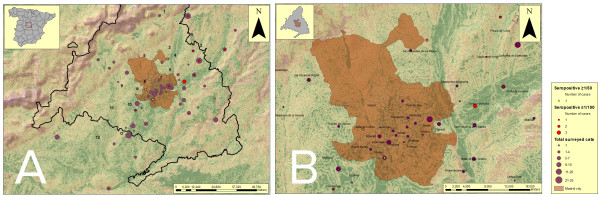
Geocoded sites where the cats were captured, shown on a digital elevation model. A. Distribution of cats seropositive for L. infantum (IFAT titre ≥ 1:50) in the study area. B. Detailed distribution of cats seropositive for L. infantum (IFAT titre ≥ 1:50) in the Madrid city area. 1: Uceda (Guadalajara); 2: Guadalajara city; 3: Fresno del Torote (CM); 4: Camarma de Esteruelas (CM); 5: San Sebastián de los Reyes (CM); 6: Alcalá de Henares (CM); 7: Torrejón de Ardoz (CM); 8: Las Rosas (Madrid city); 9: Casa de Campo (Madrid city); 10: Orcasur (Madrid city); 11: Fuenlabrada (CM); 12: Carranque (Toledo). **For 3 seropositive cats (two showing a titre of 1:50 and 1 of 1:100), the capture site was unknown so they do not appear on the map.